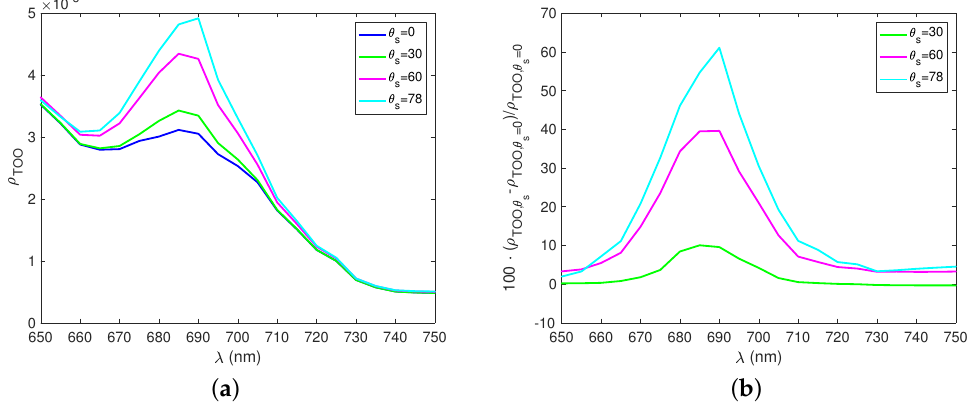
Figure 5. ( a ) The nadir viewing reflectance at TOO as a function of wavelengths for different solar zenith angles. [Chla] = 10.0 mg/m 3 and the aerosol optical depth at 550 nm is 0.1. ( b ) The percentage differences of fluorescence signals at TOO for different solar zenith